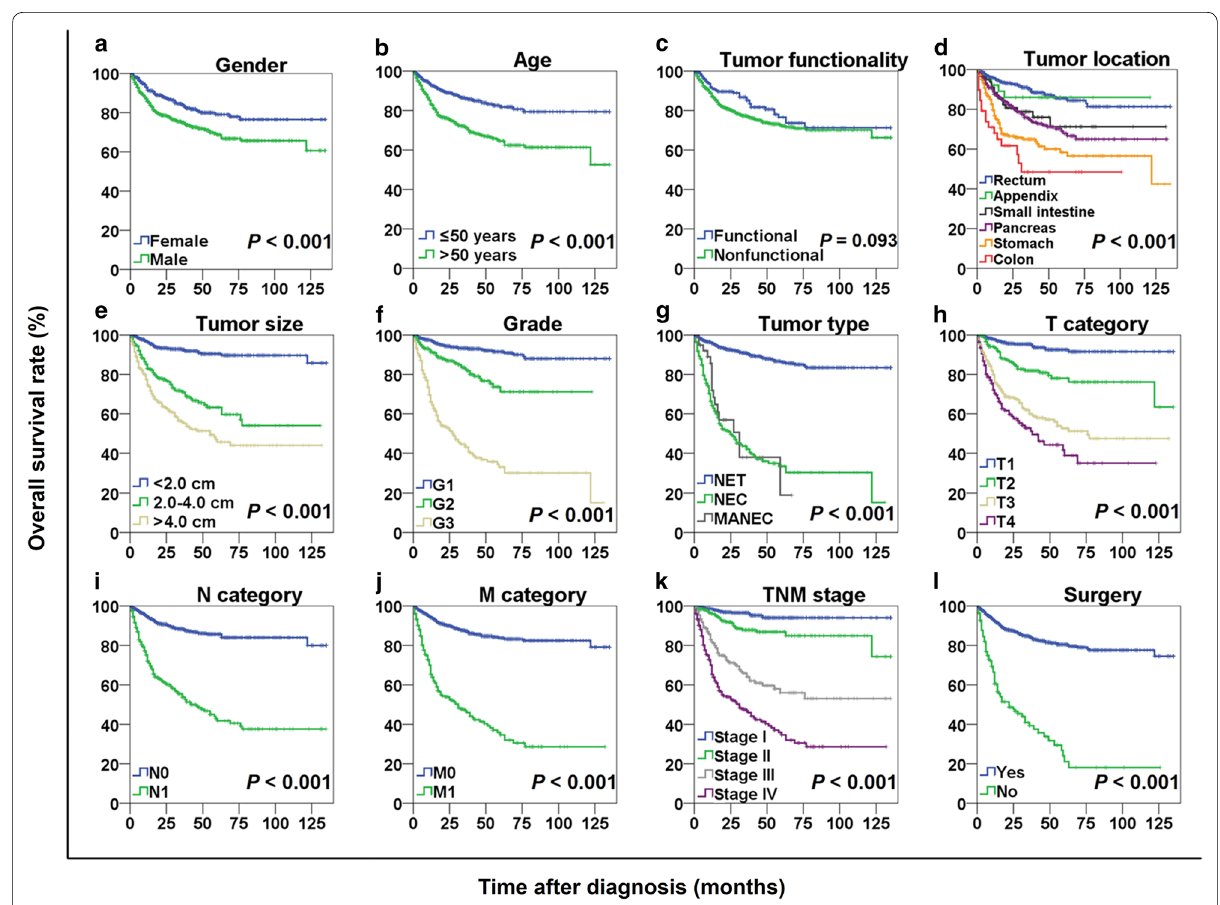
Fig. 1 Overall survival (OS) curves stratified by different variables in 1183 patients with gastroenteropancreatic neuroendocrine neoplasms (GEP-NENs). OS curves stratified by gender ( a ), age ( b ), tumor functionality ( c ), tumor location ( d ), tumor size ( e ), tumor grade ( f ), tumor type ( g ), T category ( h ), N category ( i ), M category ( j ), TNM stage ( k ), and surgery ( l ). OS was different among subgroups stratified by all variables (all P < 0.001) except tumor functionality ( P 0.093). NET neuroendocrine tumor, NEC neuroendocrine carcinoma, MANEC mixed adenoneuroendocrine carci- =